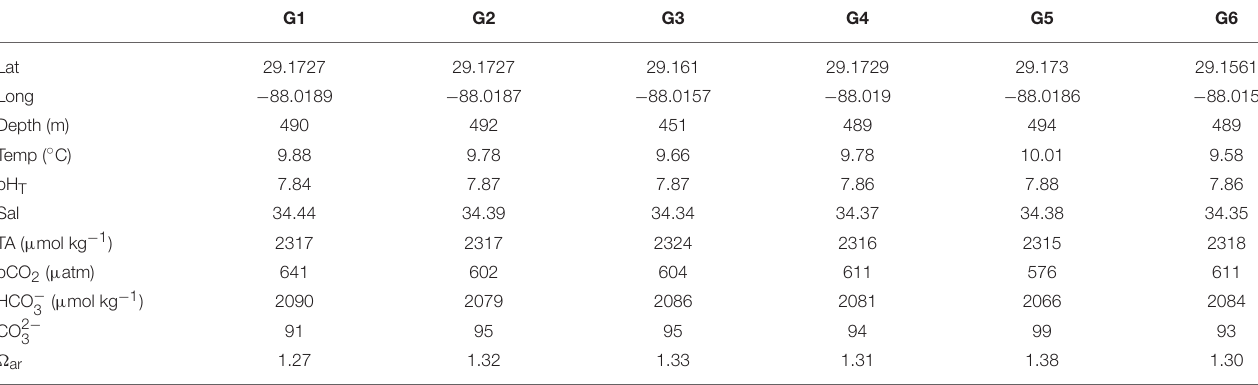
TABLE 1 | Collection sites for each of the different genotypes used in the present study with its respective in situ carbonate chemistry conditions.